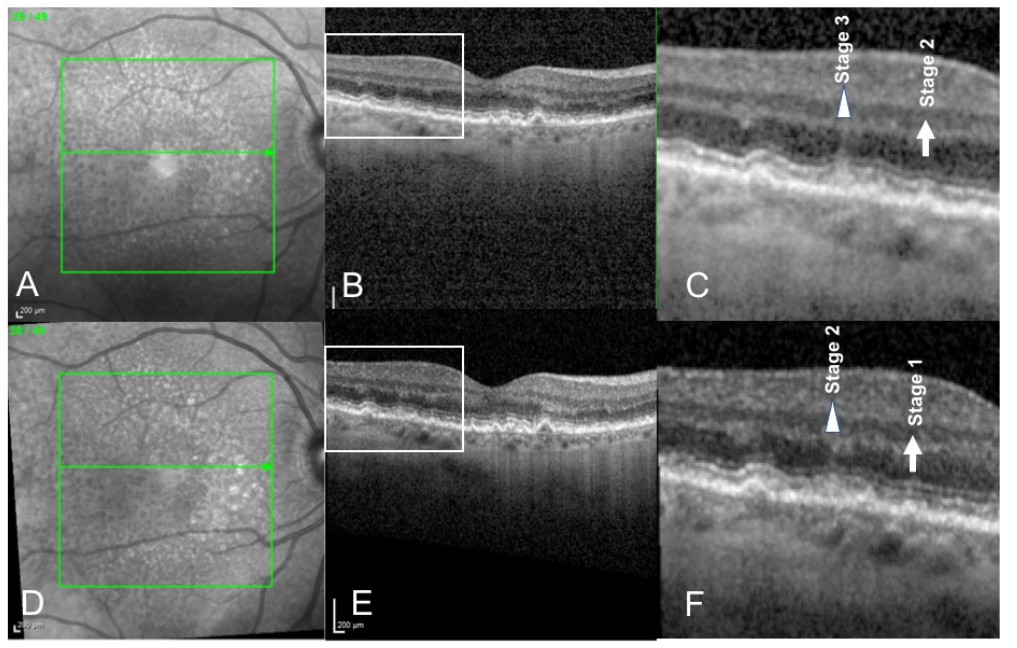
Figure 2. Spectral Domain Optical Coherence Tomography (SD-OCT) scans of a 76-year-old female patient presenting with reticular pseudodrusen, before ( A – C ) and 6 months after photobiomodulation treatment ( D – F ). Infrared imaging ( A , D ). SD-OCT scan showing redicular pseudodrusen before ( B ) and after ( E ) treatment. We can observe that a stage 3 reticular pseudodrusen (triangle, ( C )) regressed into a stage 2 (triangle, ( F )) reticular pseudodrusen 6 months after treatment. Similarly, a stage 2 reticular pseudodrusen (arrow ( C )) regressed into a stage 1 reticular pseudodrusen (arrow, ( F )) 6 months after photobiomodulation treatment.